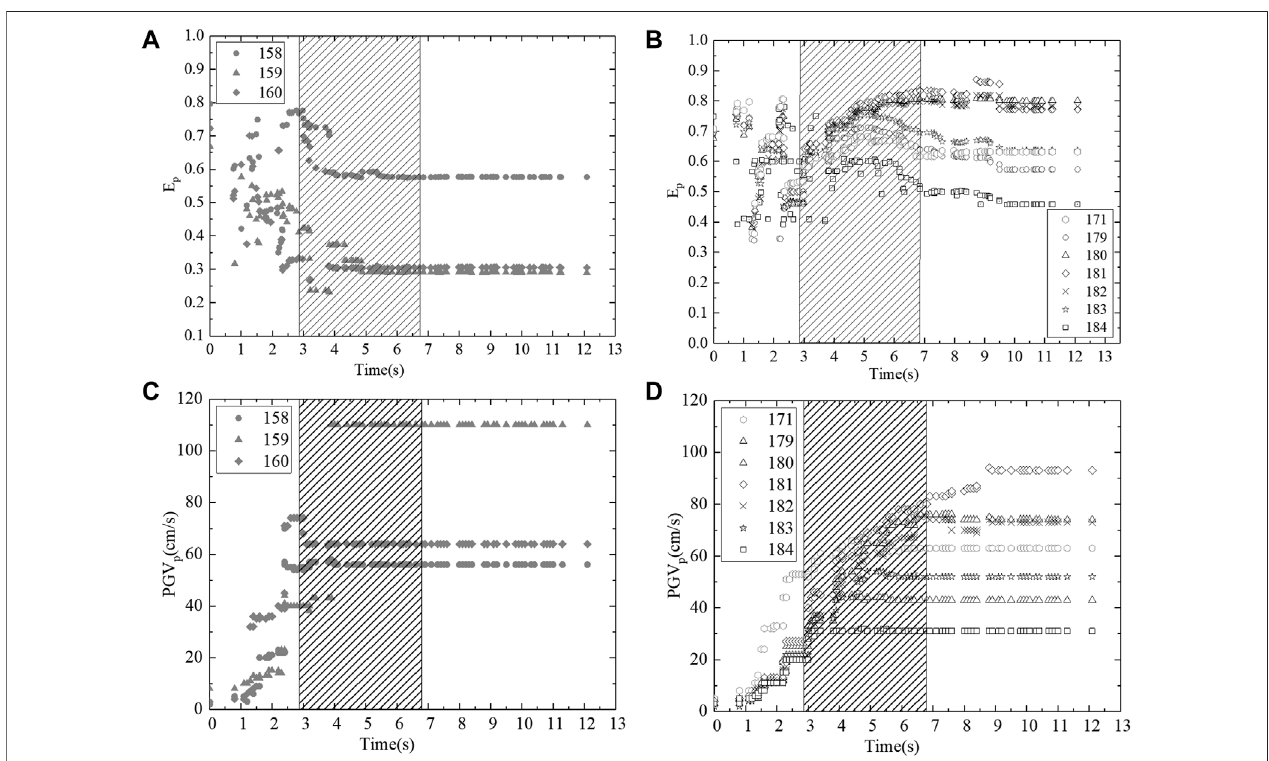
FIGURE5| E p valuesof fi nalgroundmotionsat (A) near-epicenterstationsand (B) rupture-directionstations; and PGV p valuesof fi nalgroundmotionsat (C) near- epicenter stations and (D) rupture-direction stations during the Imperial Valley Earthquake.